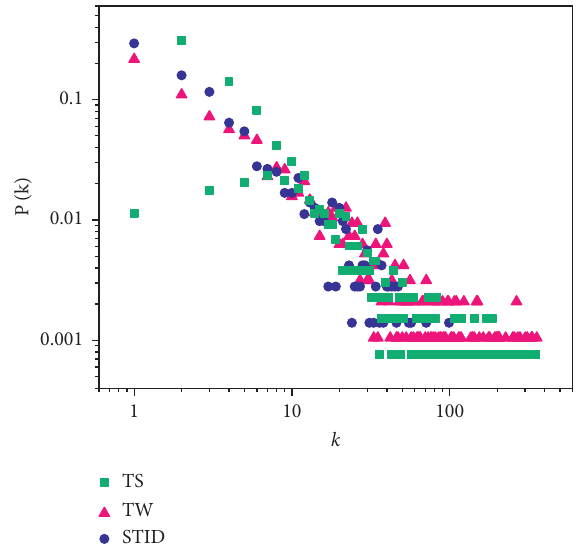
Figure 2: Degree distribution comparisons of TS (green dots), TW (pink dots), and STID (blue Table 2: The average path length, clustering coefficient, and small- worldness index of the networks. L represents the average path length while L r in the brackets represents that of a random network. C represents the average clustering coefficient while C brackets represent that of a random network. S is the small- worldness index.